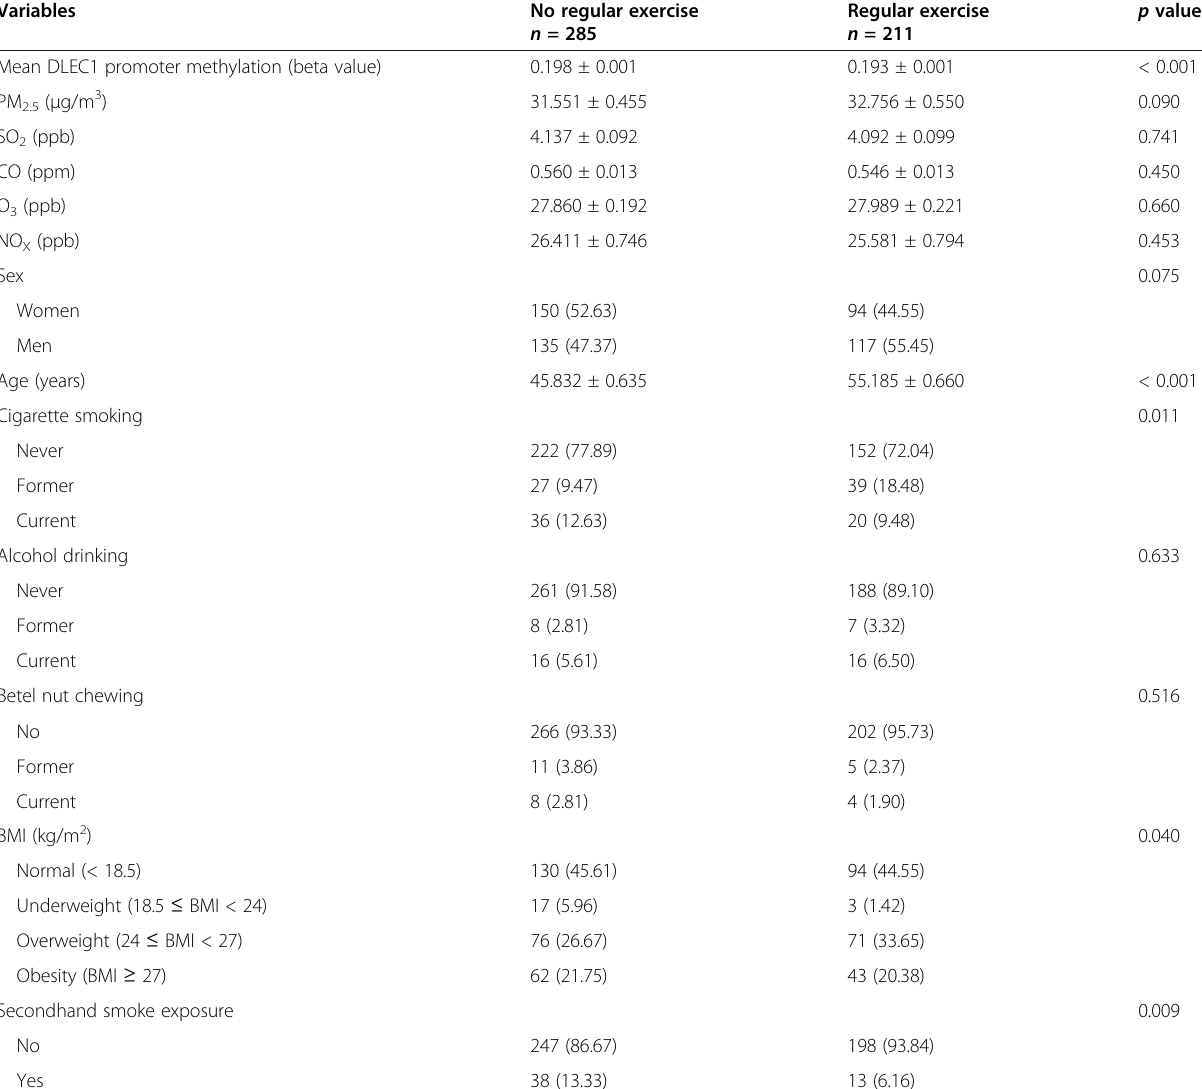
Table 1 Demographic characteristics of participants stratified by regular and no regular exercise Variables No regular exercise n =